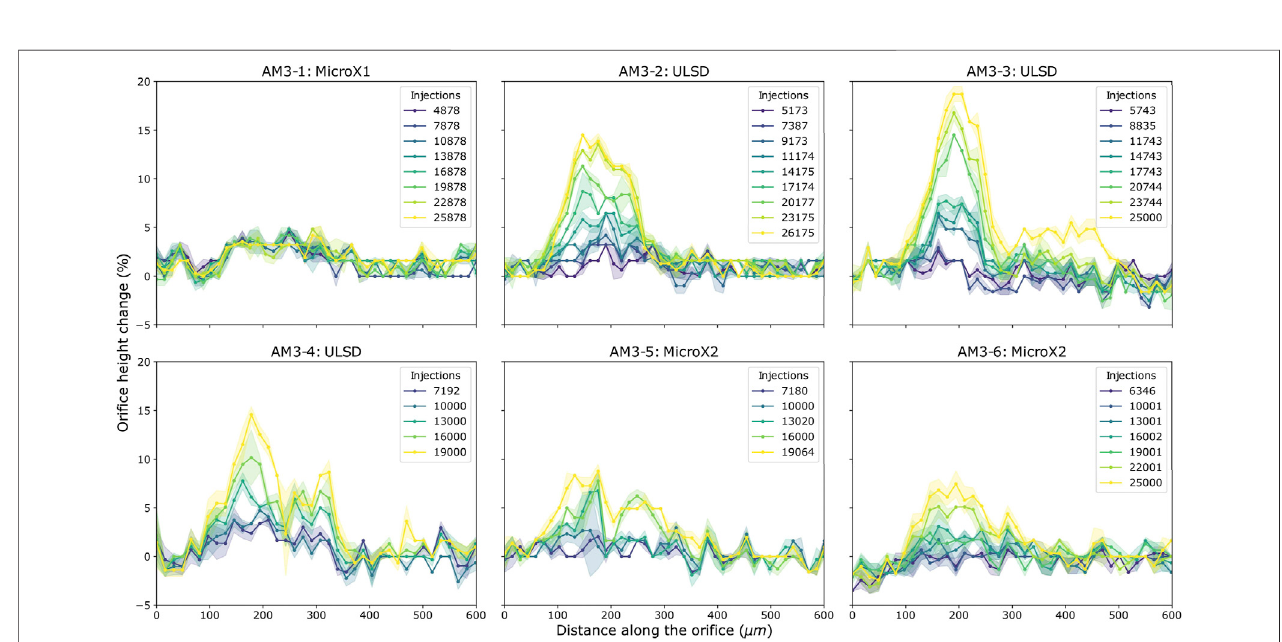
FIGURE 8 | Ori fi ce height measured using X-ray imaging, normalized by the baseline ori fi ce height at zero injections.